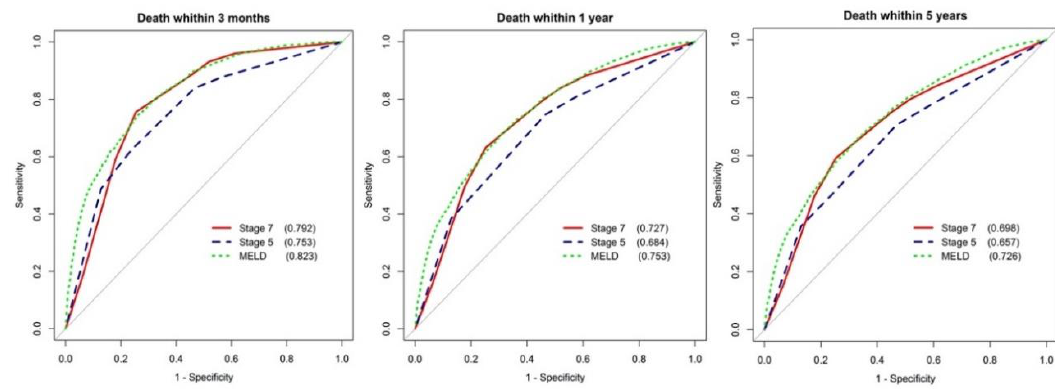
Figure 2. Comparison of the areas under the receiver operating characteristic (AUROC) of the five-stage and seven-stage models, as well as the MELD at 3 months, one year, and the entire follow-up period (5 years).